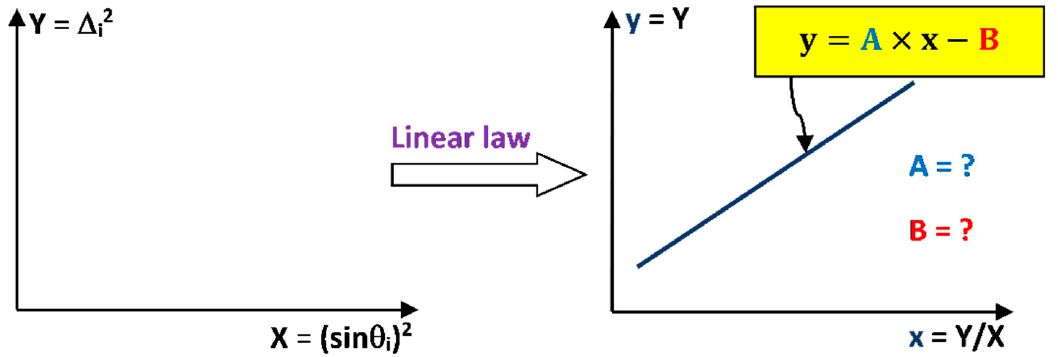
Figure 9. Application of linear law (x, y) for non-linear relation (X, Y). Table 2. Values for drawing the linear function (x, y).